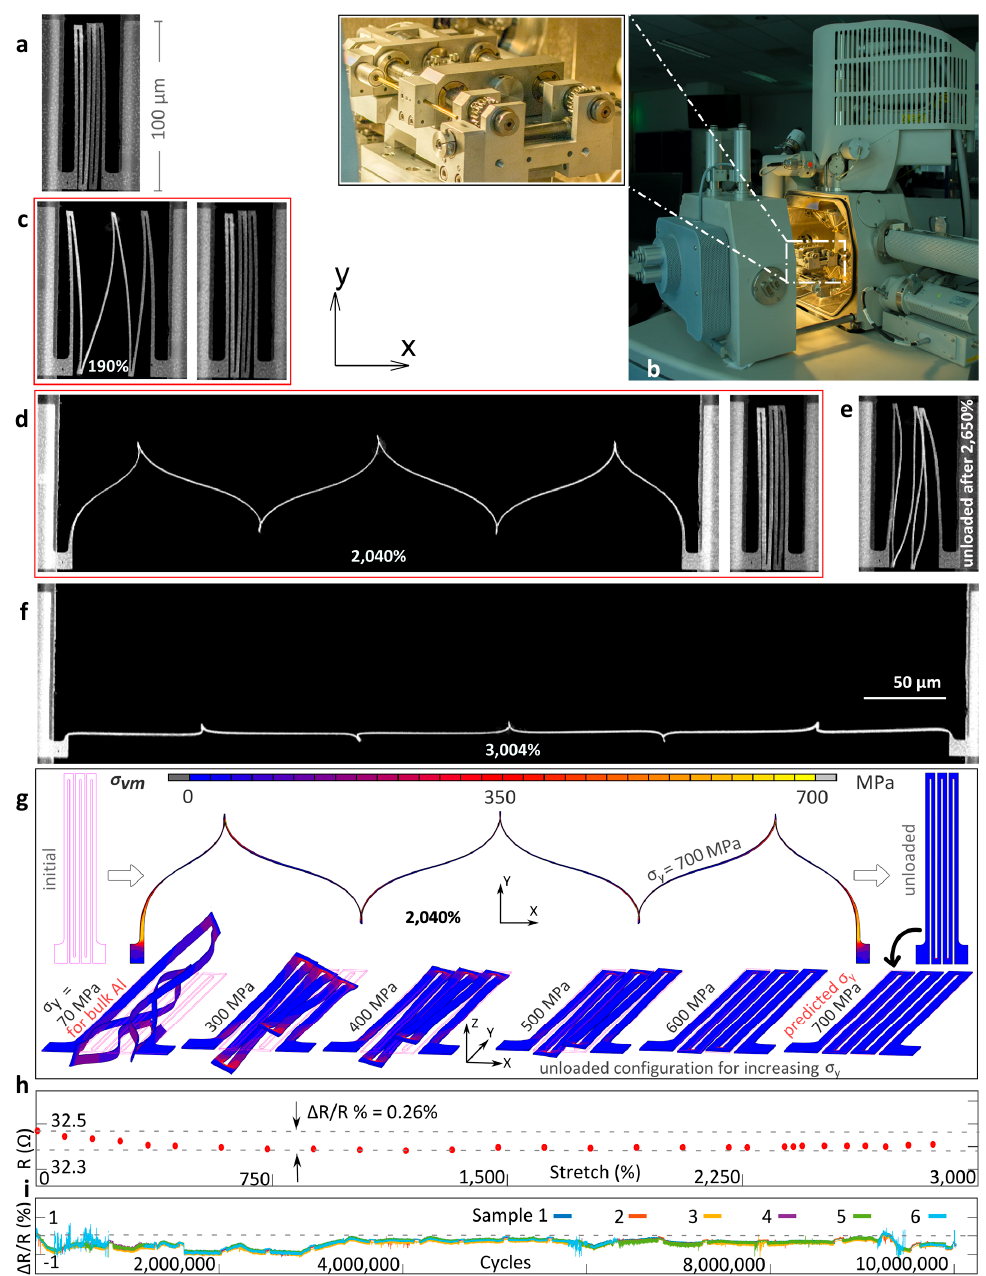
Figure 4. Selected experimental and numerical results. ( a ) The initial (load-free) state of the interconnect structure with a beam length, width, and thickness of 100, 2, and 0.3 μ m, and gap of 1 μ m; ( b ) Microtensile stage placed inside a large chamber scanning electron microscope (SEM), with a magnified view of the tensile stage; ( c , d ) Demonstration of reversible stretchability: in each stretching cycle, the interconnect structure is stretched to an incrementally higher global strain (left igure), while the shape after unloading (corresponding right figure) should be compared with the initial configuration; ( e ) Beyond 2040% global stretchability, plastic deformation sets in, which becomes clearly visible after unloading from the 2650% stretched state; ( f ) The ultimate (plastic) stretchability is reached beyond 3000% global strain. Exactly the same deformation behavior was observed for the other four parallel structures in the field of view (Figure S1 in the Supplementary Materials section); ( g ) finite element method (FEM) elastoplastic simulation at 2040% global strain (compare with ( d )), for a yield stress of 700 MPa: equivalent von Mises stress overlaid on the stretched configuration (left) and subsequent unloaded configuration (right); (below) Unloaded configurations for increasing yield strength values, showing that the yield stress is at least σ y = (700 ± 100) MPa; ( h , i ) Electrical resistance measurements ( h ) for a quasi-static stretch to 3000% and ( i ) during 10 million cycles of 1000% elastic